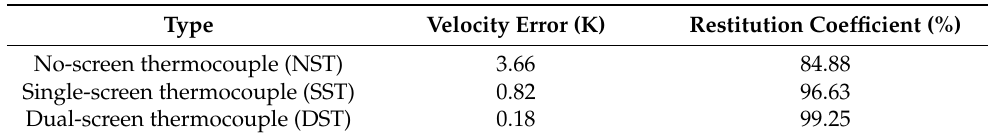
Table 1. The velocity error σ V and restitution coefficient r of three types of thermocouple, NST, SST, and